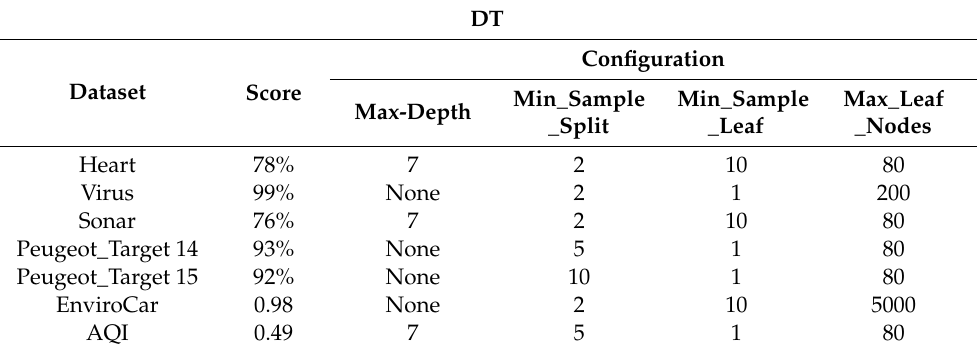
Table 26. DT performance and configuration for PCA =